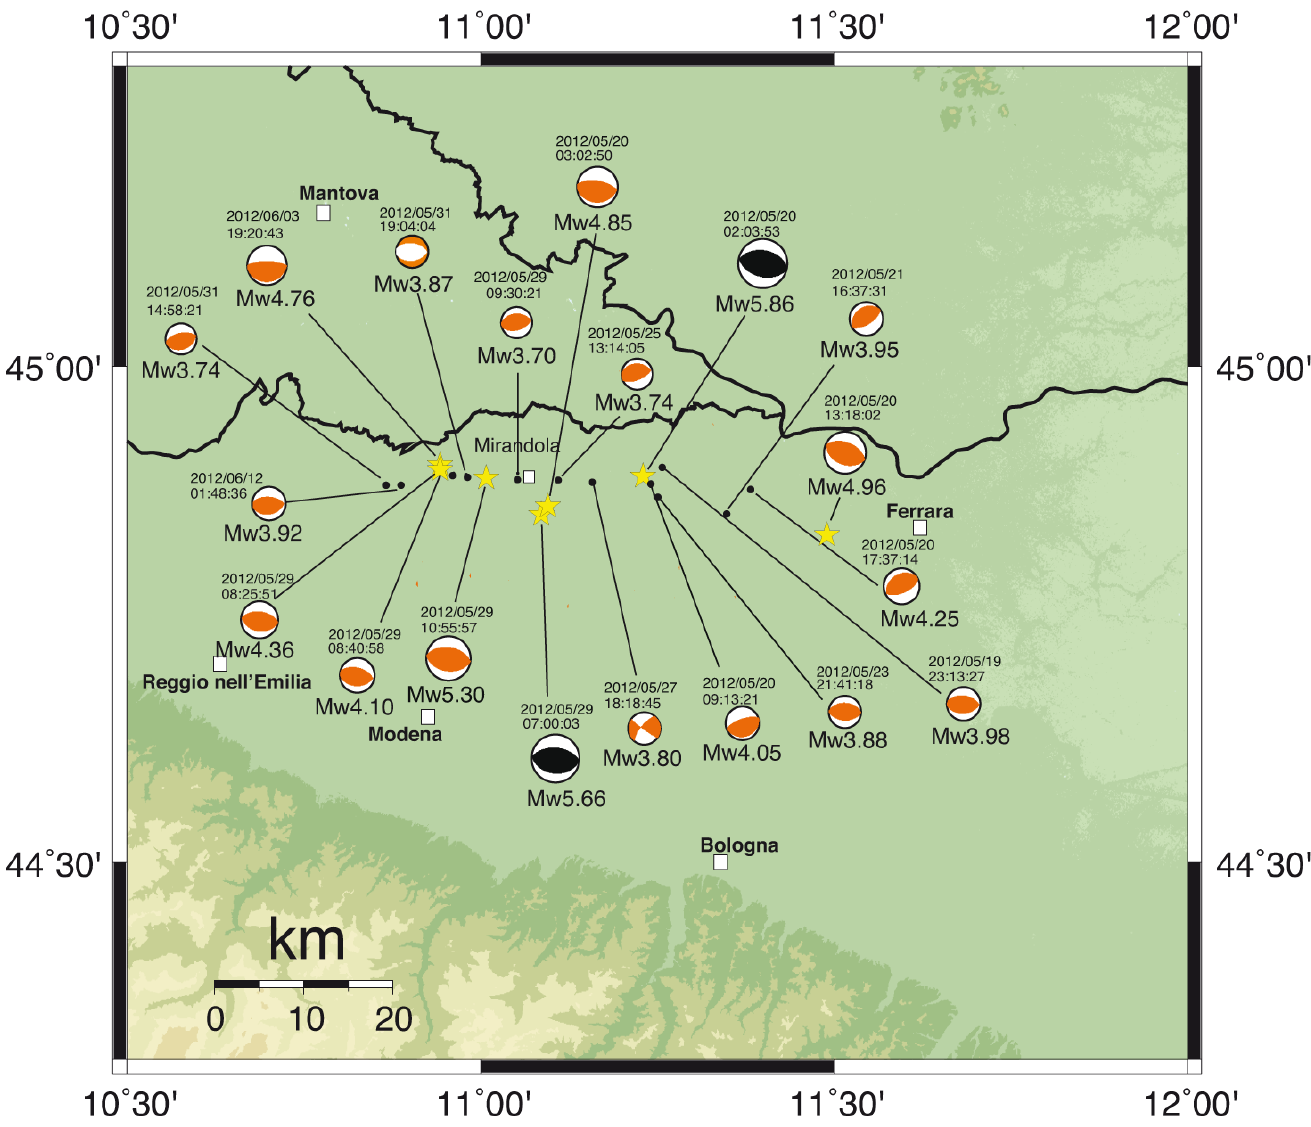
≥ 4.0, determined using the TDMT technique. Black, the two mainshock L